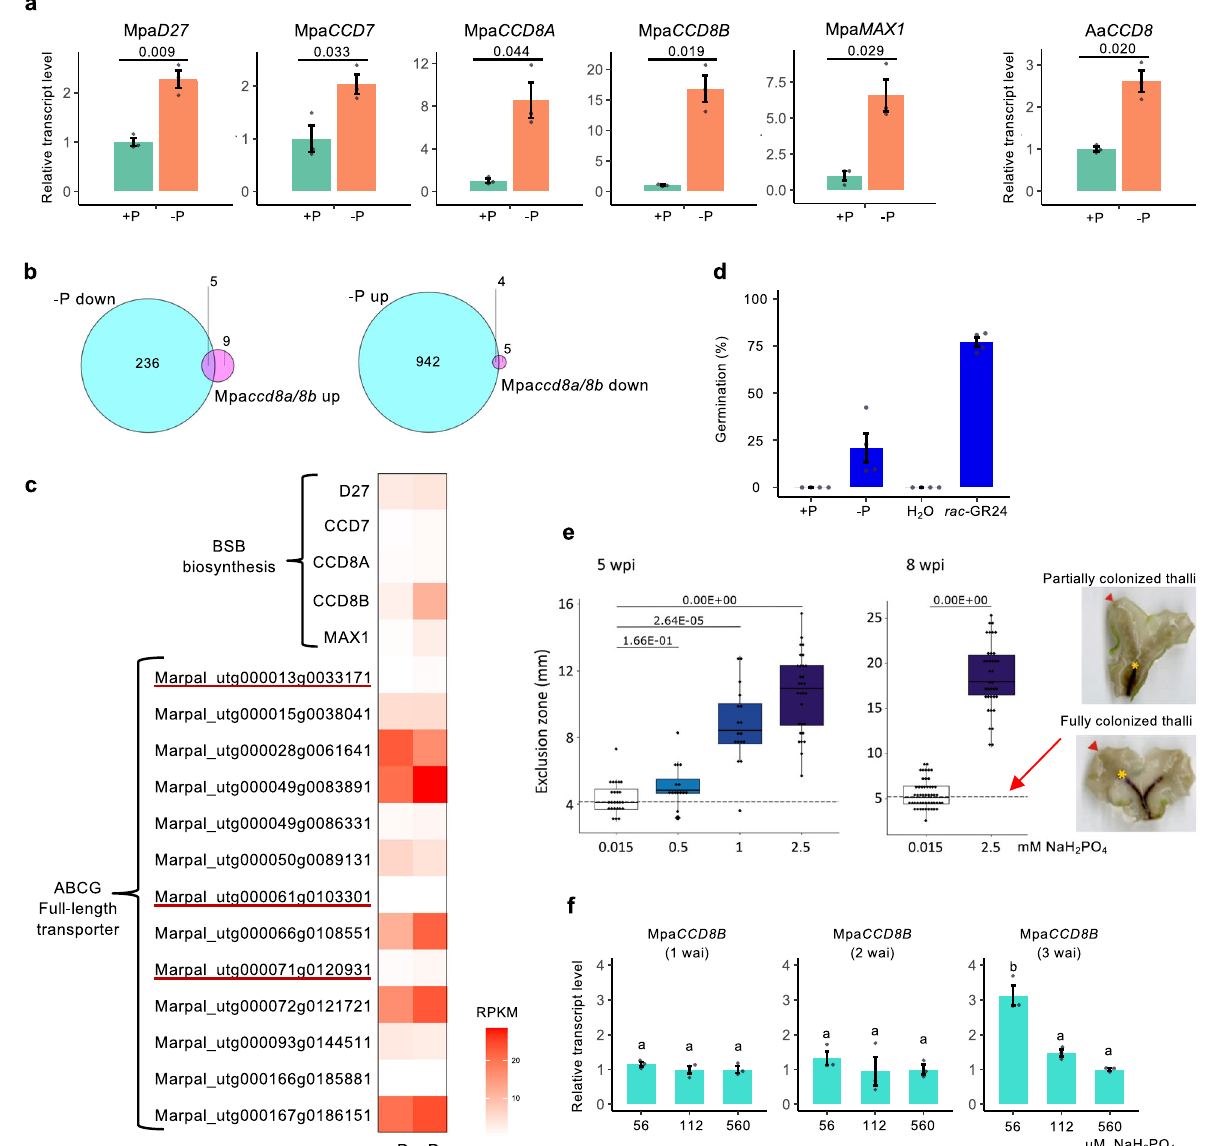
Fig. 4 Enhanced BSB synthesis correlates with an AM symbiosis permissive state. a Increased transcript level of the SL biosynthesis genes, Mpa D27 , Mpa CCD7 , Mpa CCD8A , Mpa CCD8B and Mpa MAX1 , of M. paleacea , and Aa CCD8 of Anthoceros agrestis under phosphate starvation. Plants were grown on half-strength Gamborg ’ s B5 medium with ( + P) or without ( − P) phosphate. Data are means ± SD ( n = 3 biologically independent samples) and p values in Welch ’ s t -test, two tailed are indicated. b Identi fi cation of DEGs under phosphate starvation and in Mpa ccd8a/8b mutants by RNA-seq analysis. Left: Venn diagram of genes down-regulated in − P condition compared to + P condition in WT (blue) and up-regulated in Mpa ccd8a/8b compared to WT (pink). Right: Venn diagram of genes up-regulated in − P compared to + P condition in WT (blue) and down-regulated in Mpa ccd8a/8b compared to WT (pink). c Heatmap of gene transcript level under phosphate de fi ciency in M. paleacea . DEGs (logFC > 1) up-regulated under – P are underlined. d Increase in the stimulation activity of the exudate of M. paleacea on seed germination of Orobanche minor under phosphate starvation. Exudates from M. paleacea grown on + P and − P medium were used for analysis. Data are means ± SD ( n = 4 biologically independent samples). e Low phosphate allows mycorrhizal colonization. M. paleacea inoculated with Rhizophagus irregularis were watered with long ashton solutions containing 0.015, 0.5, 1 or 2.5 mM phosphate. Right: Cleared thalli of M. paleacea grown in low phosphate (bottom right) show a higher level of fungal colonization (marked by a natural purple pigment) than thalli grown at high phosphate (upper right). The exclusion zone which is the distance between the notch (harrow) and the end of the colonized zone (yellow asterisk) was measured ( n ≥ 15 biologically independent plants). Box plot shows fi rst quartile, median, third quartile, whiskers 1.5 interquartile. p values (one-way ANOVA, post hoc Tukey) are shown. f Developmental stage-dependent induction of Mpa CCD8B transcript level in response to low phosphate conditions. Gemmalings of 1 – 3 weeks after inoculation (wai) were transferred to media containing different concentrations of phosphate. Data are means ± SD ( n = 3 biologically independent samples) and the HSD test was used for multiple comparisons. Statistical differences ( p values < 0.05) are indicated by different